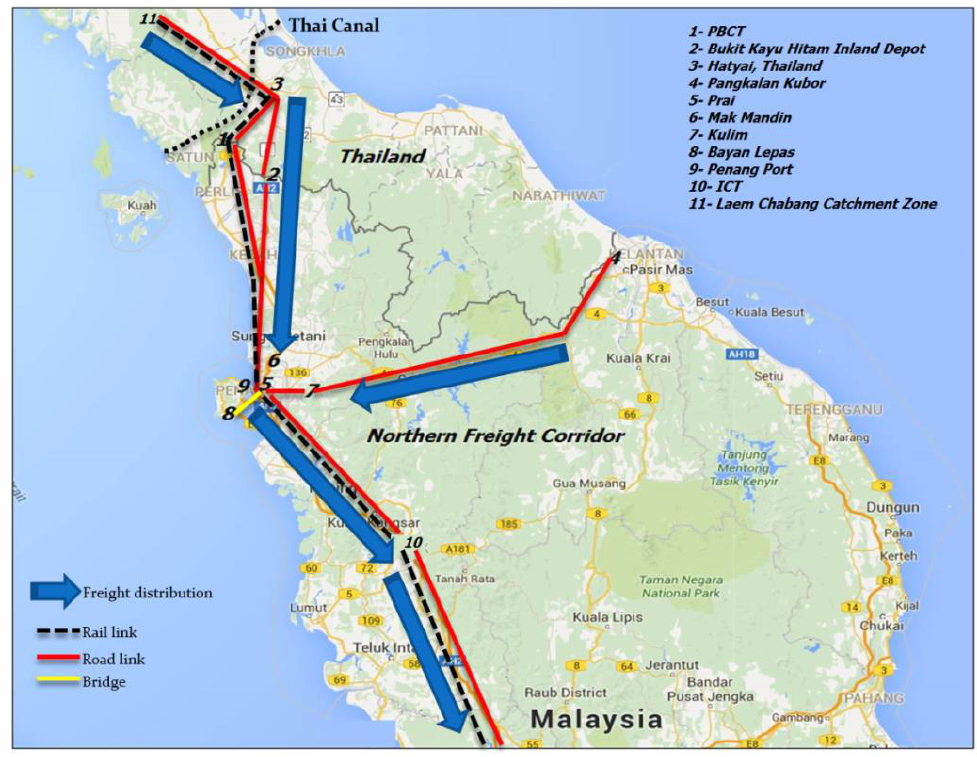
Figure 3: Trade facilities in northern region peninsular Malaysia